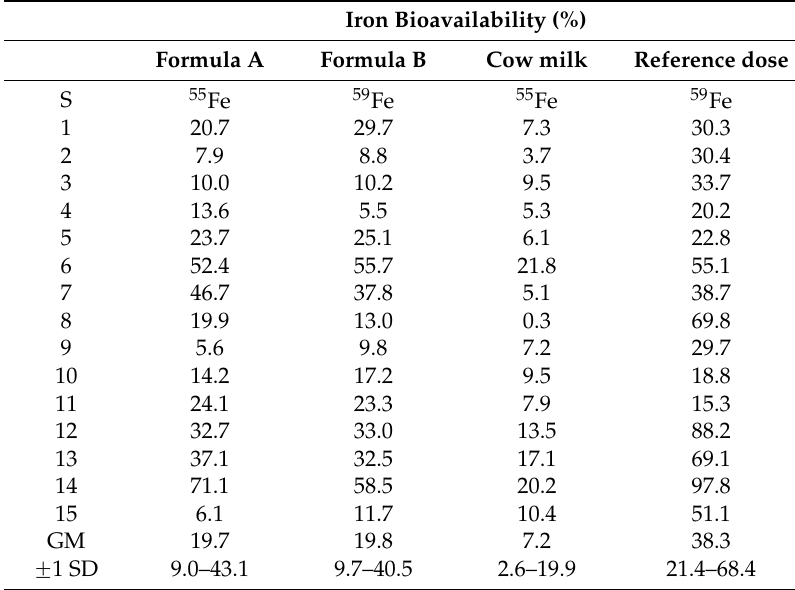
Table 3. Iron bioavailability of Formula A, Formula B and cow’s milk.